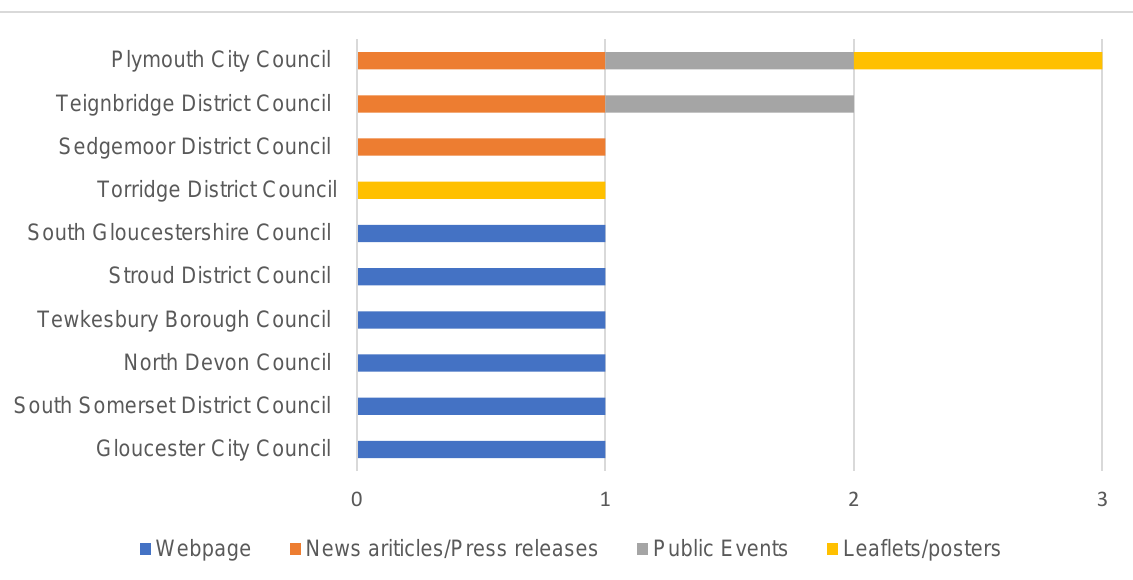
Figure 4. Methods used to publicise Registers for LPAs in Figure 3. Source: LPA Freedom of Information Responses.